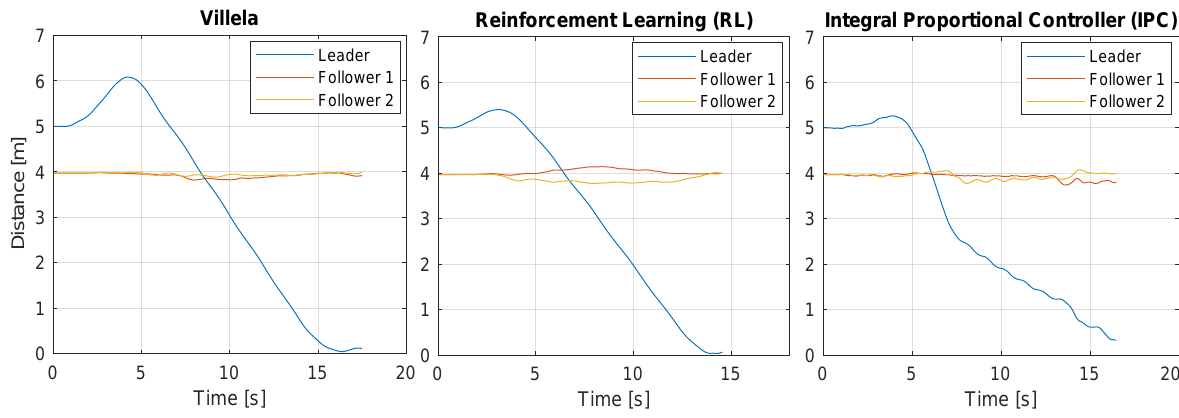
Figure 17. Positions of the robots for all